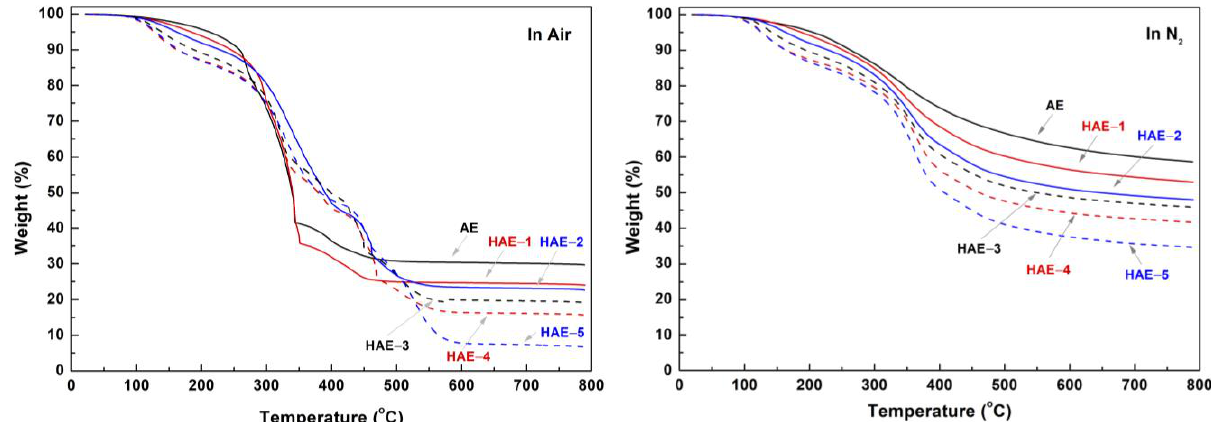
Figure 7. TGA of AE and HAEs in oxidative (air) and inert (N 2 ) conditions.